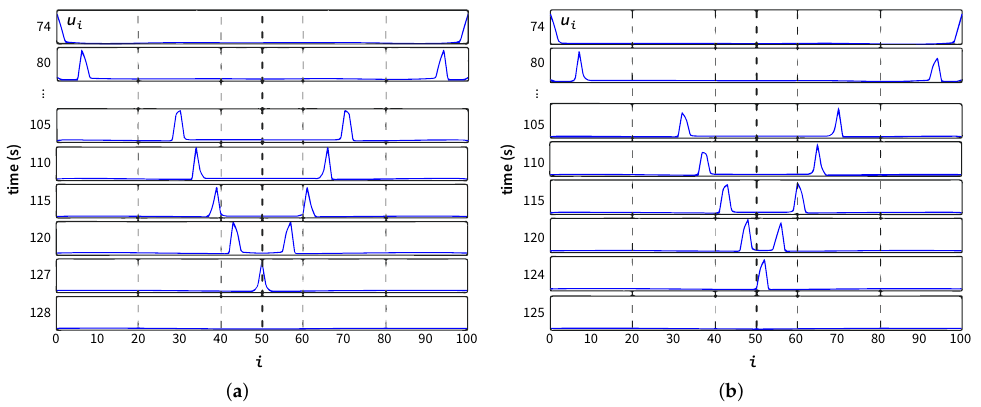
Figure 5. Space and time evolution of the waves on the 1-d RD circuit comprised of 100 Oregonator elements and the connectivity achieved with ( a ) resistors or ( b ) memristors. ( a ) In the absence of the memristive characteristics of the circuit, the waves travel at the same speed and collide at the middle of the architecture. ( b ) Whereas, in the case of the memristive behavior being present the collision of the waves happens at the right side and close to the middle of the configuration.